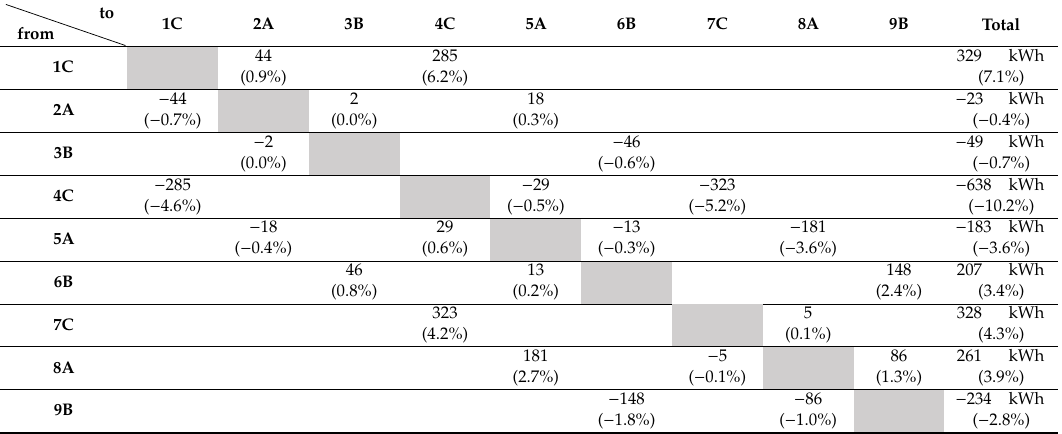
Table 4. Percentage * of heat given or stolen between adjacent apartments, base